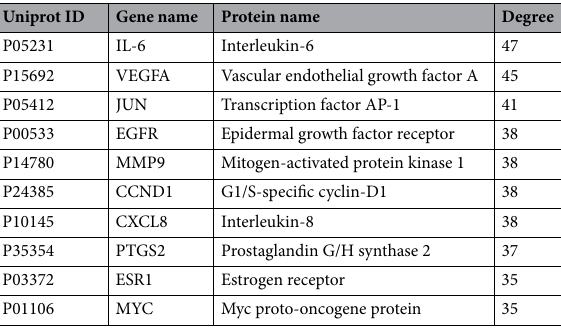
Table 1. Key target information table of Que in the treatment of AF.